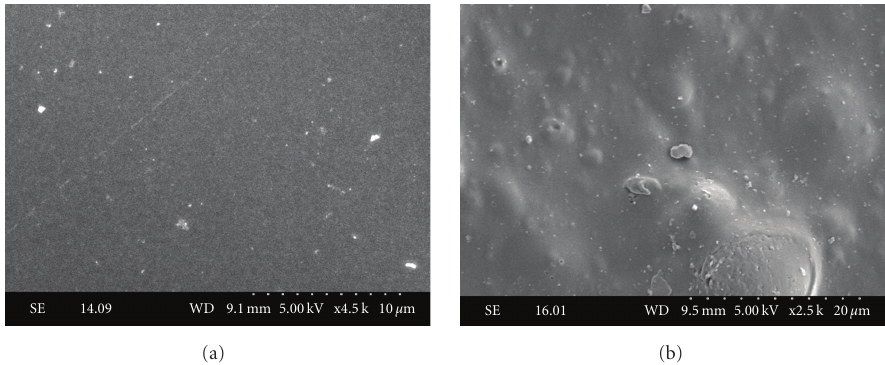
Figure 1: Microstructure of noncontaminated glass (a) and polystyrene (b) substrates observed under a scanning electron microscope.